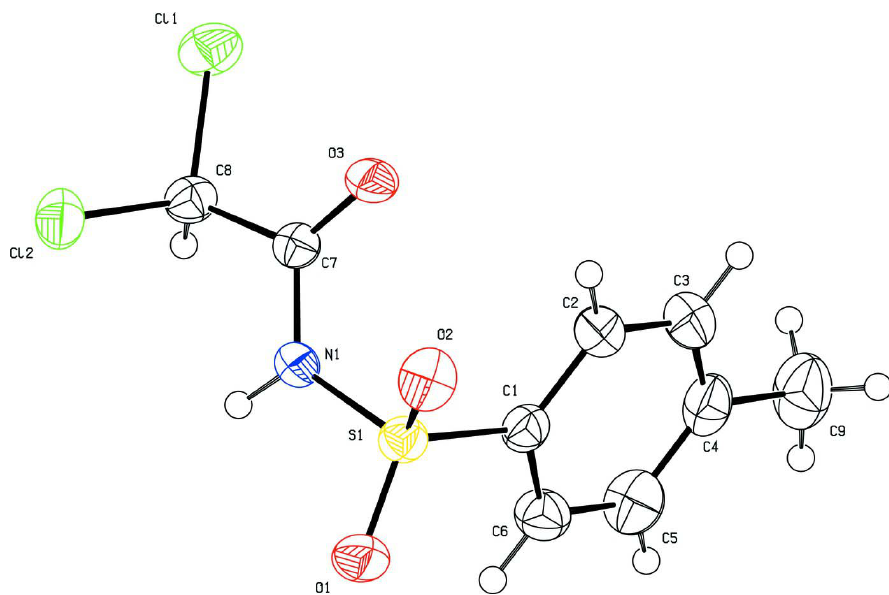
Figure 1 Molecular structure of (I), showing the atom labeling scheme. The displacement ellipsoids are drawn at the 50% probability level. The H atoms are represented as small spheres of arbitrary radii.